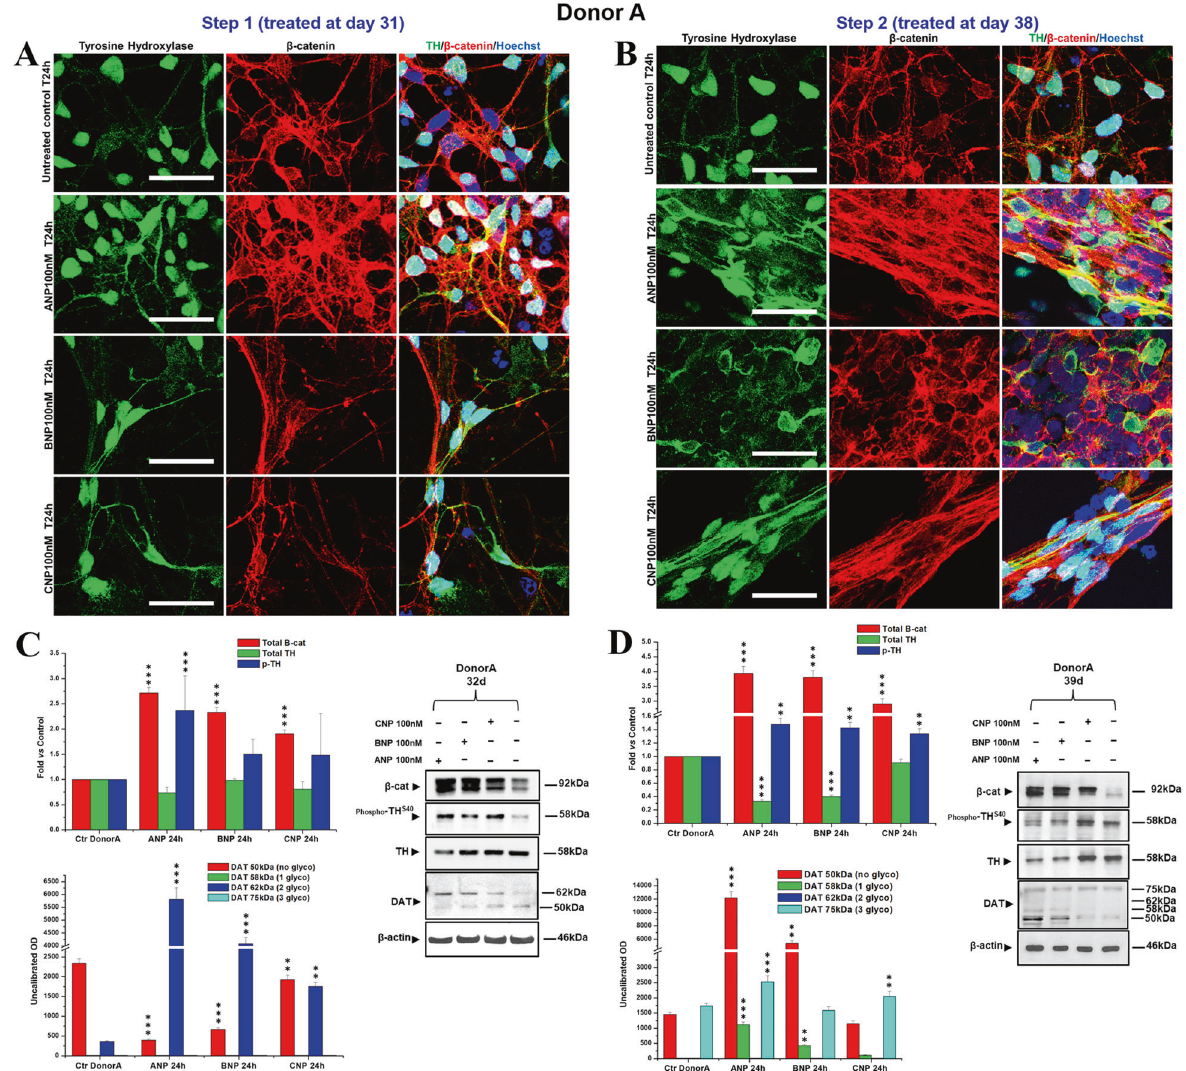
on the expression and intracellular distribution of TH ( green hue ) and β -catenin ( red hue ), compared with the untreated control. Merged images of β -catenin/TH double immuno fl uorescent staining and nuclei counterstaining with Hoechst ( blue hue ) are also shown. Bars 25 µm. C , D WB analyses of the effects of NPs treatments, at day 31 (Step 1; C ) or at day 38 (Step 2; D ) of total β -catenin, total and phosphorylated TH (pTH at Ser40), and of unglycosylated (50 kDa), mono- (58 kDa), di- (62 kDa), and tri- (75 kDa) glycosylated forms of the dopamine transporter DAT. In the densitometric analysis, values were normalized to β -actin, or vs. the total levels of total TH for phosphoTH S40 . Results are the mean ± SD from three independent experiments ( n = 3). Signi fi cance vs. the untreated control (one-way ANOVA + Tukey multiple comparison test): ** p < 0.01, *** p < 0.001. Additional results from the one ‐ way ANOVA test used to analyze the differences between groups are reported in Supplementary